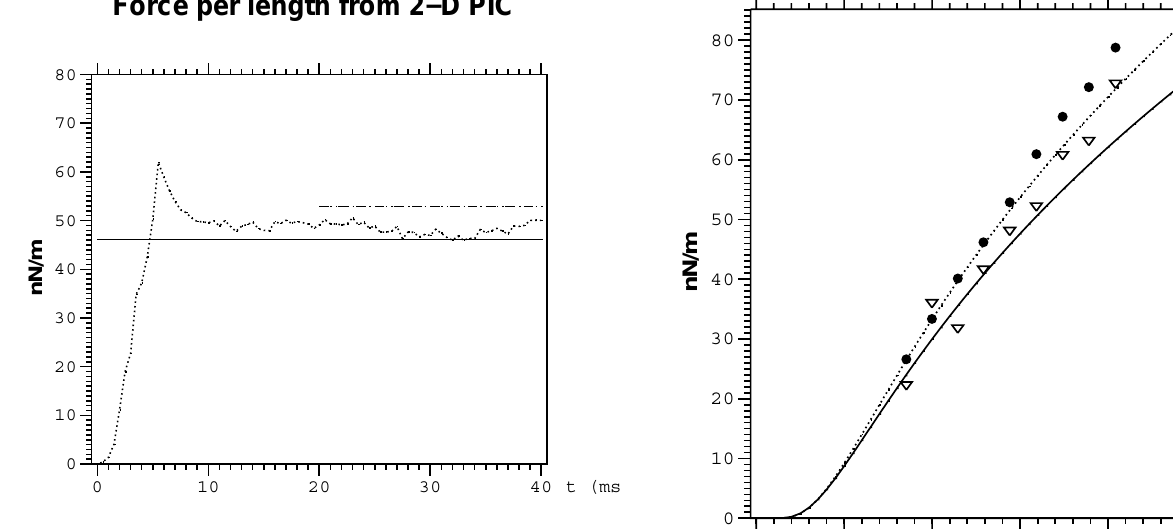
Fig. 5. Force per unit length from 2-D PIC simulation as a function of time using the Coulomb force method (method 1, dotted) and the particle momentum method averaged over 20–40ms (method 2, dashed). The risetime of the wire potential was set to 5ms. The solid line shows the model result from Eq. (8).